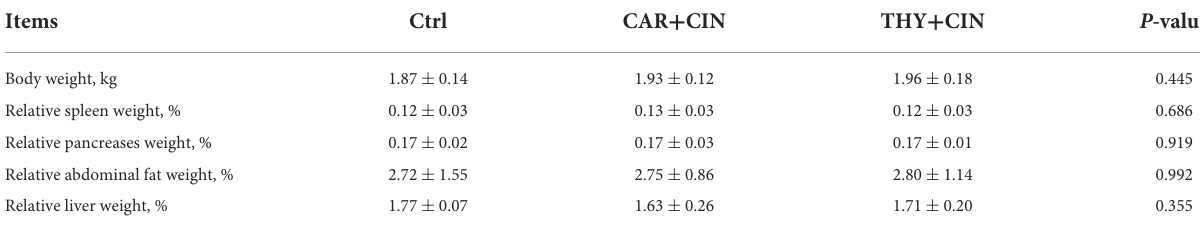
TABLE 5 Effects of dietary treatments on body weight and organ size of post-peak laying hens.